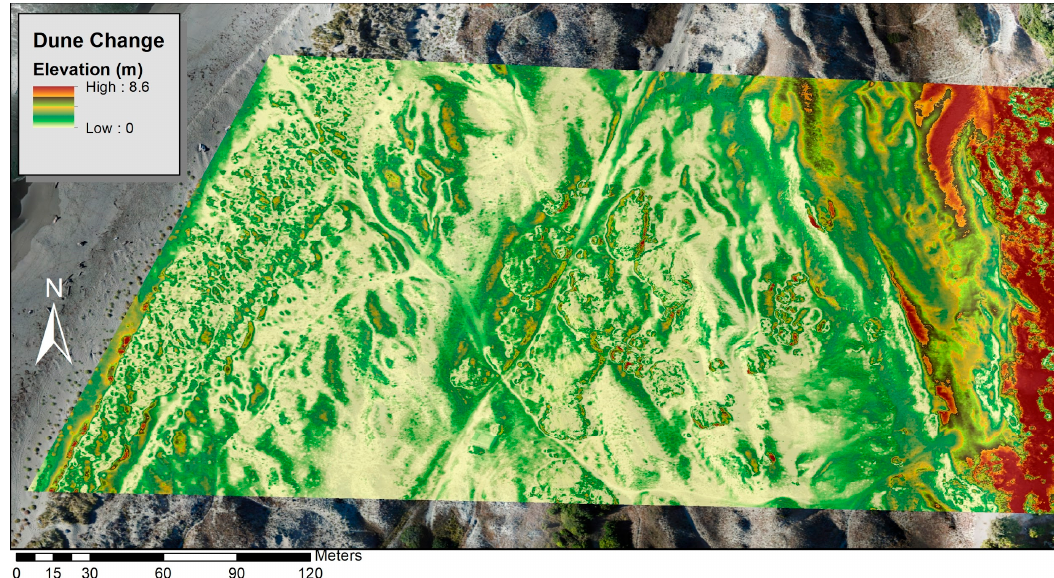
Figure 5. Map showing the differences in the two digital surface models (DSMs) (2019 UAV-derived DSM and 2018 UAV-derived DSM) emphasizing the shifts in dune movements in a year.